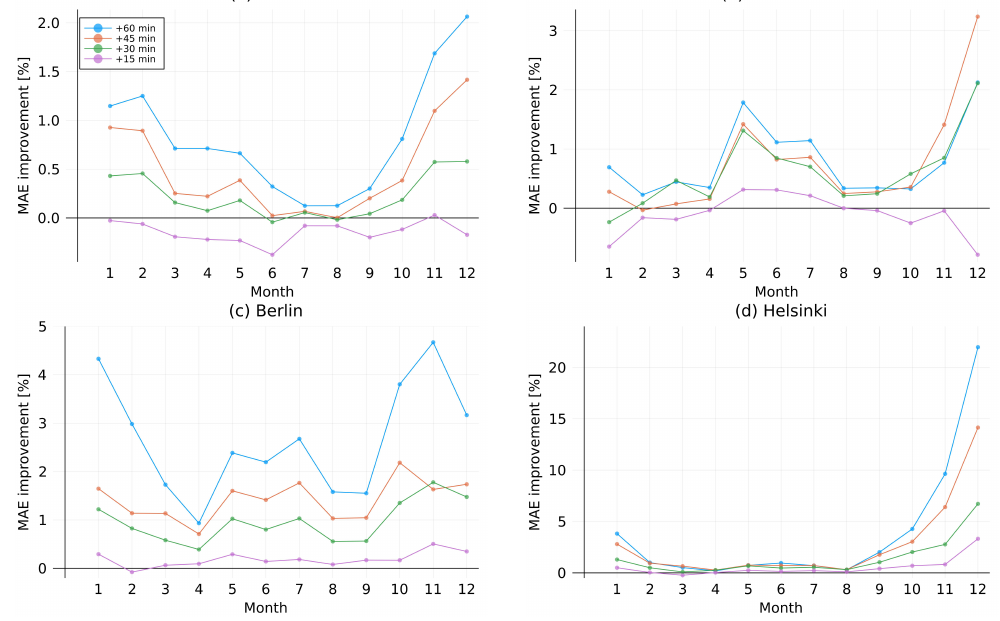
Figure 16. Relative improvement of the hybrid approach in 2020 for ( a ) Athens, ( b ) Bucharest, ( c ) Berlin, and ( d )